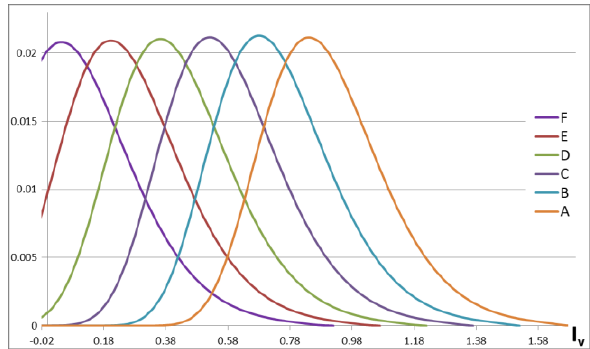
Figure 4. Distribution of probability of belonging of a building in classes A to F as a function of the vulnerability